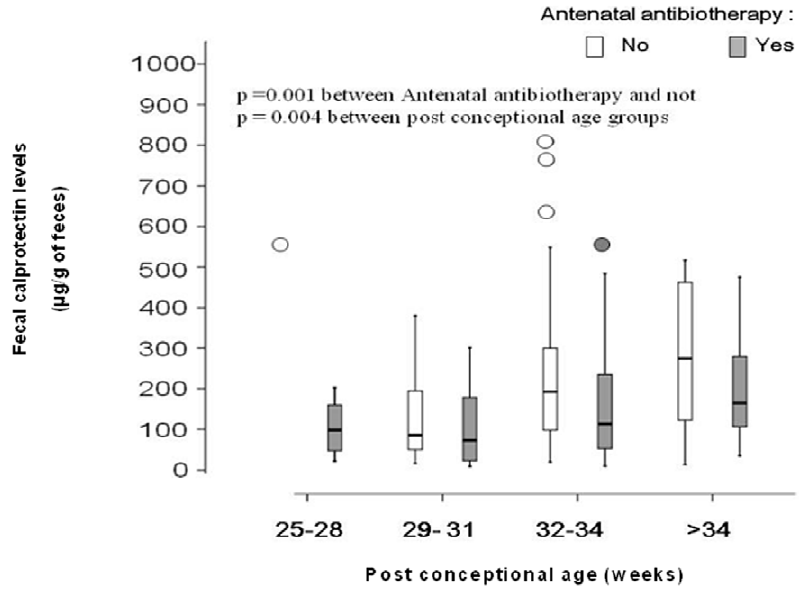
Figure 1. Fecal calprotectin levels in preterm infants with or without antenatal antibiotherapy. The boxplot shows the median (central horizontal line) and includes the 25 th (lower box border) to 75 th percentile (upper box border) of fecal calprotectin ( m g/g of feces) in preterm infants with (74 fecal samples) and without (73 fecal samples) antenatal antibiotherapy following the postconceptional age (weeks).